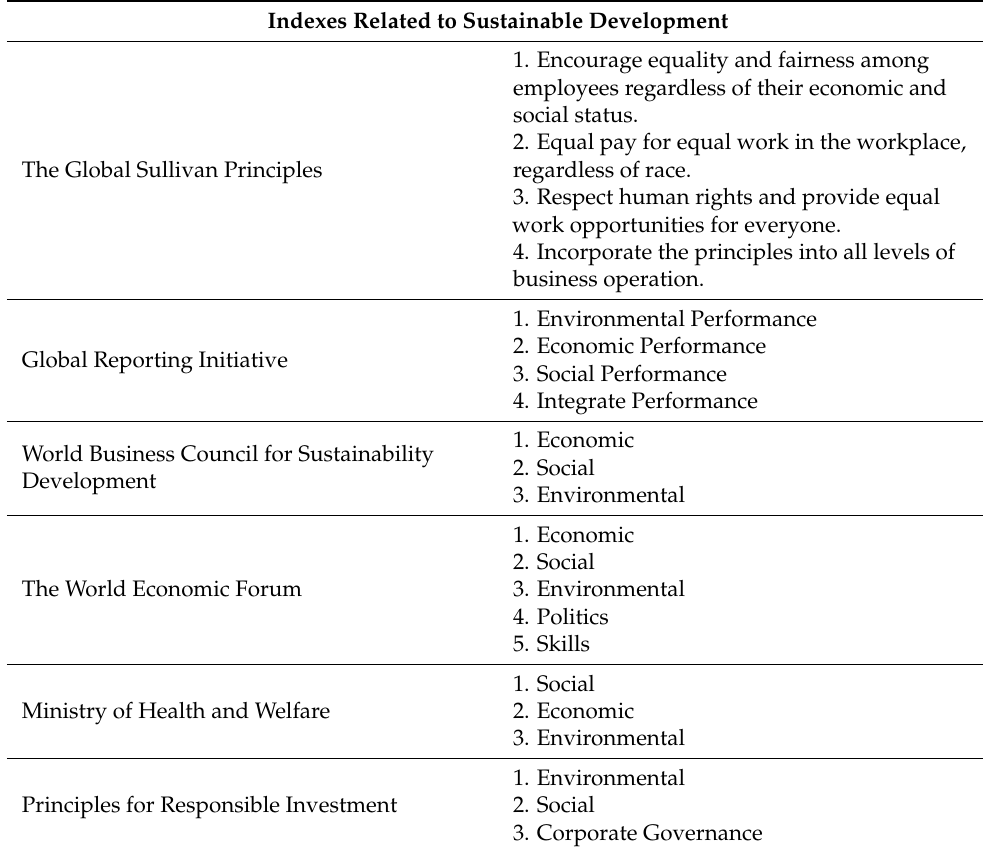
Table 1. Literature concerning indices related to sustainable